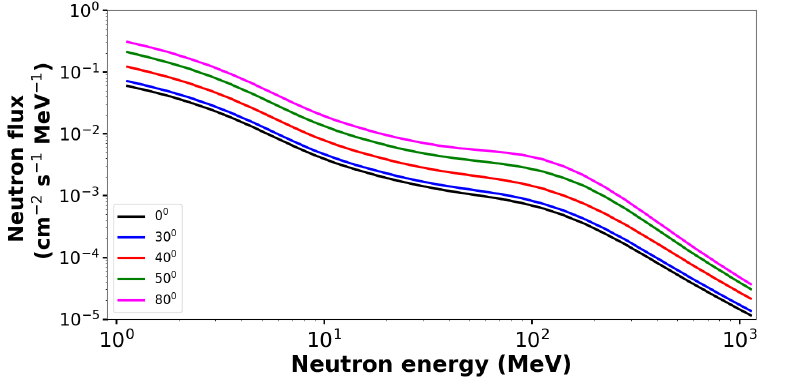
Figure 2. Atmospheric neutron spectra for various latitudes at geographical points with an altitude of 10 km and a longitude of 0 ◦ . See text for more